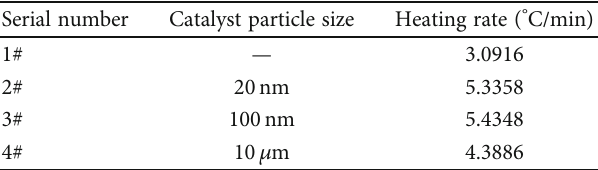
Table 3: Heating rate of each